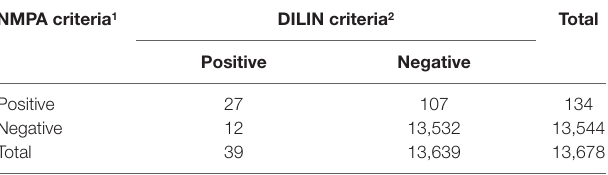
TABLE 6 | Agreement between the DILIN criteria and NMPA